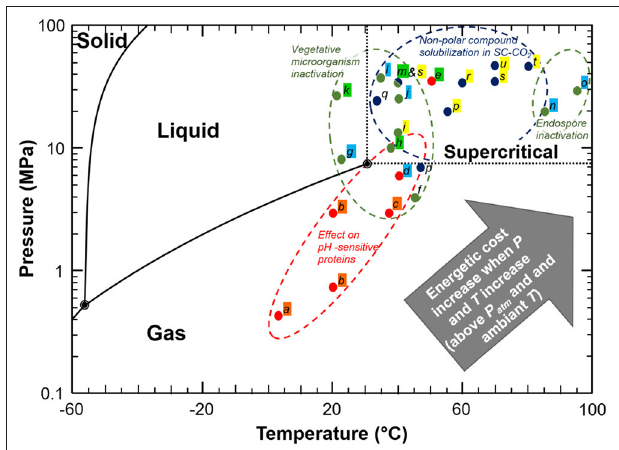
FIGURE 4 | Representation of effective CO 2 treatments on a phase CO 2 diagram. Lettering is described in Table 1 . Coloured highlight indicates the name of the different CO 2 treatments as mentioned in the corresponding studies: Orange, CO 2 acidification (carbonation); Blue, HPCD; Green, DPCD; Yellow, SC-CO 2